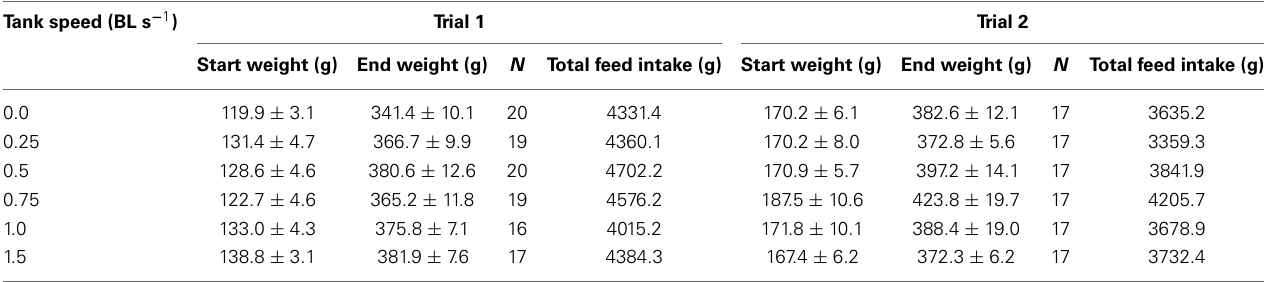
Table 1 | The starting weight (g), final weight (g), total feed consumed (g), and number of fish in each of Trial 1 and Trial 2. Tank speed (BL s − 1 )